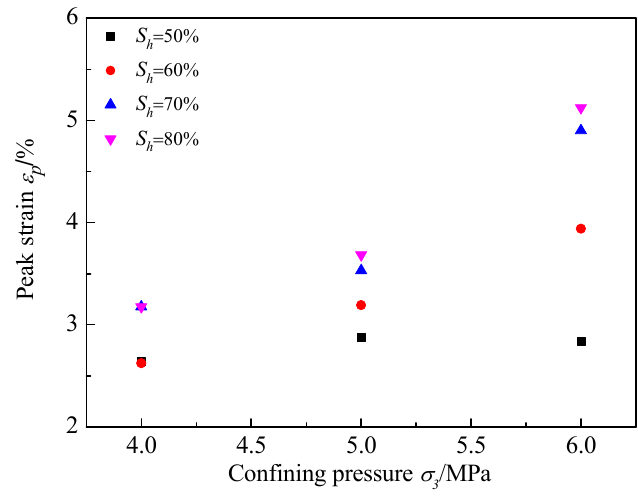
Figure 14. Variation of the peak strain with the confining pressure.